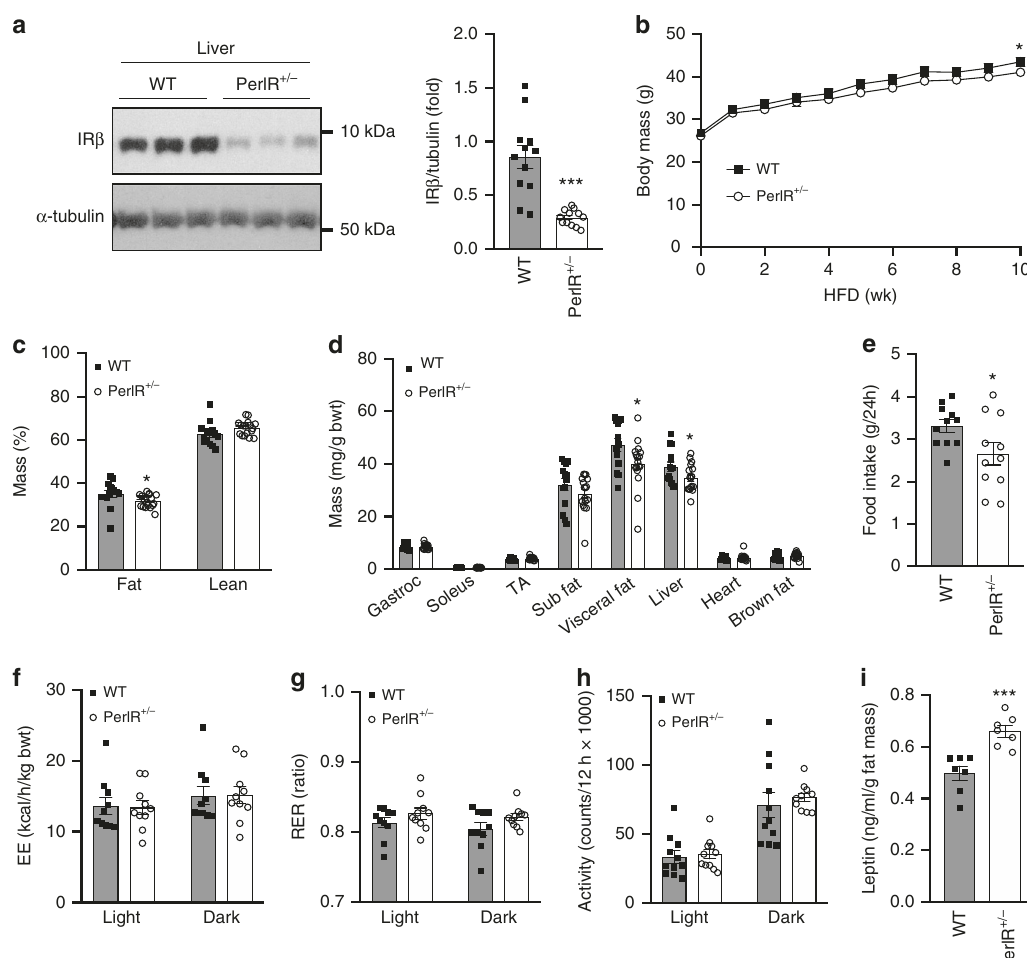
Fig. 1 The effect of partial peripheral tissue IR disruption on body composition and energy expenditure in adult mice fed a high-fat diet. Ten days following tamoxifen (TX) treatment, male mice were fed a high-fat diet (HFD) and liver insulin receptor (IR) β expression a , body mass b , body composition c , d , food intake e , energy expenditure (EE) f , respiratory exchange ratio (RER) g and activity levels h were determined, as well as plasma leptin i . Results are shown as means ± SE, with n ’ s represented as individual data point ’ s in fi gures. For body weight n = 13 for WT and 17 for PerIRKO + / − . Signi fi cance was determined using two-tailed student ’ s t test. * p < 0.05, *** p < 0.001 vs WT. Gastroc: gastrocnemius muscle, TA: tibialis anterior muscle, Sub: subcutaneous, visceral fat is the epididymal fat